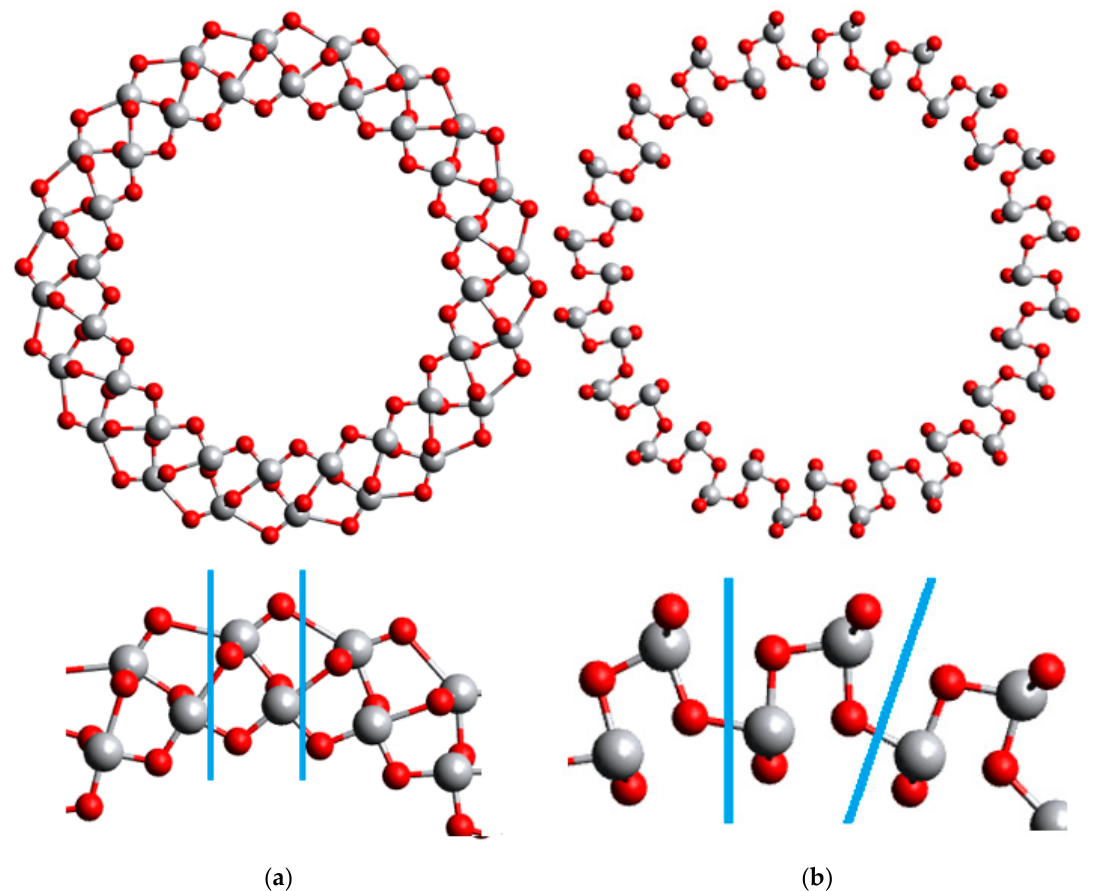
Figure 2. Structures of 6-layered (001) TiO 2 NTs. Unit cells are depicted with blue lines in the magnified segments. ( a ) ( n ,0) configuration; ( b ) (0, n ) configuration. Table 1. Parameters of 6-layered (101) ( n ,0) TiO 2 NTs, simulated with and without water. The lattice parameter corre- sponding to NT axis is denoted with a , d stands for outer diameter, b —for outer b constant along NT circumference, and a × b —their